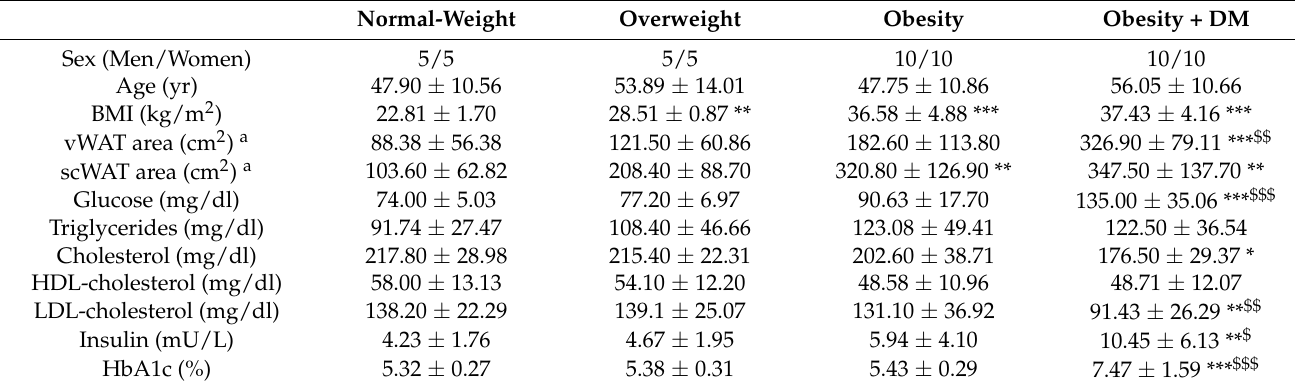
Table 2. Baseline characteristics and biochemical parameters of the different groups within the cohort.